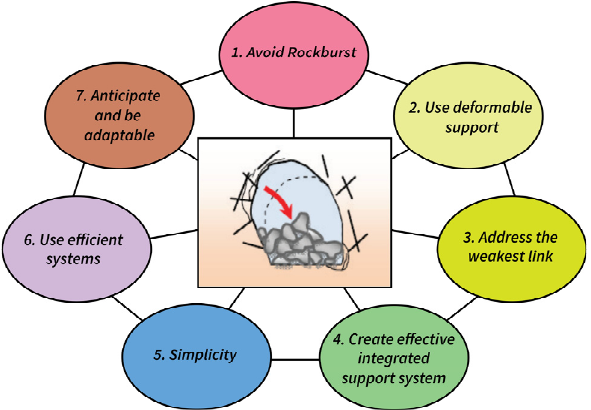
Figure 16. Seven principles of rockburst mitigation and support selection principles [2].